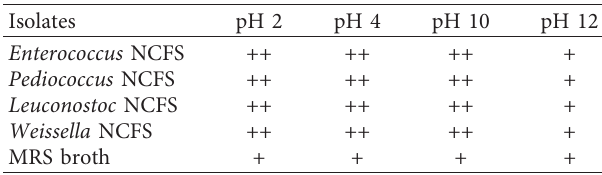
Table 8: Inhibitory activity of CFS following different pH treat- ments ( S. aureus ATCC25923 was used as an indicator bacterium).